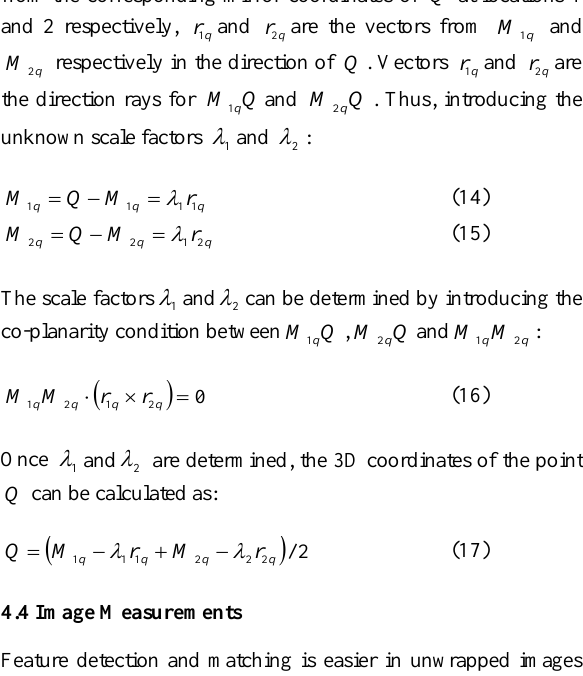
and can r r q 2 q 1